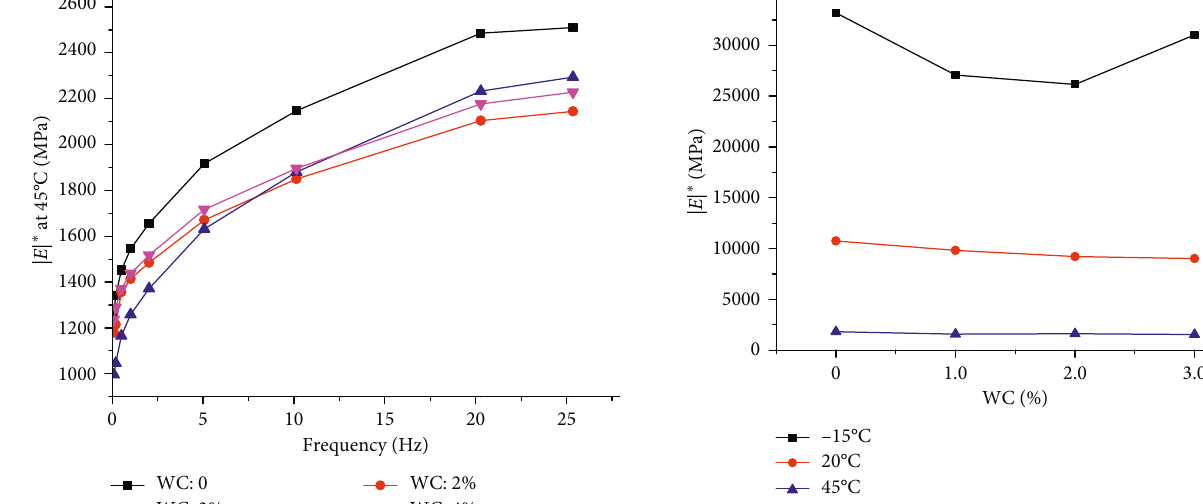
Figure 18: 90#AC-20-type dynamic modulus varying with water consumption and